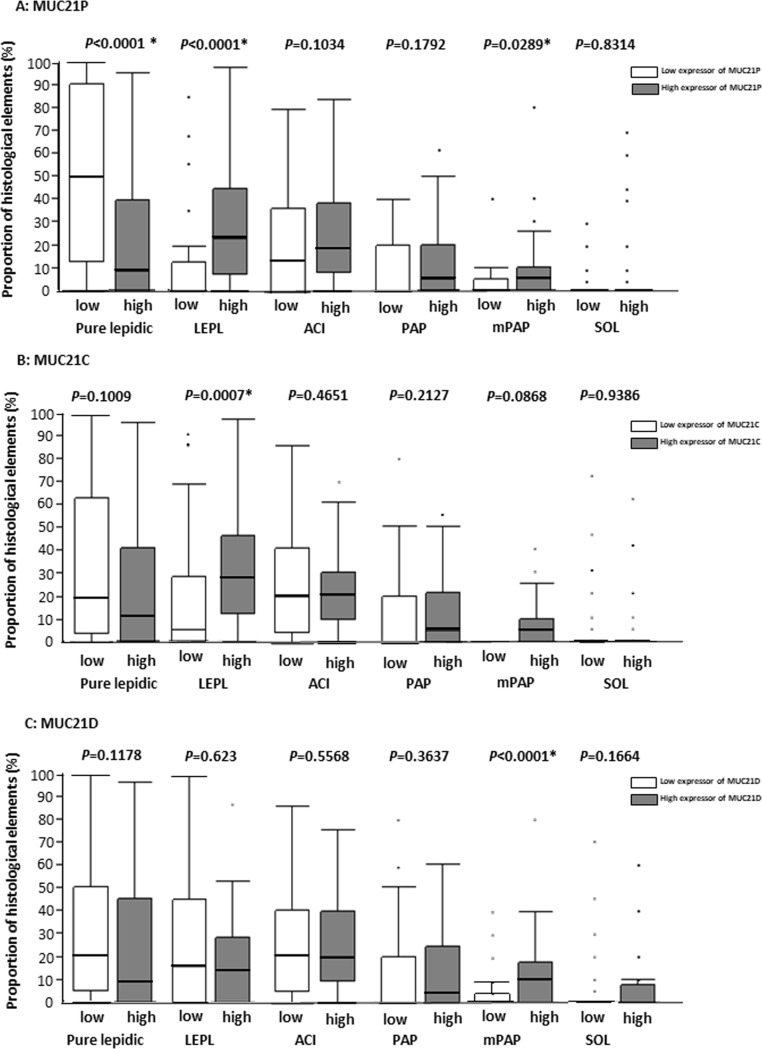
The correlations between the proportions of histological elements and the levels of MUC21 immunohistochemical expressions.Proportions of histological elements are displayed as a box-and-whiskers plot (median, thick line; 25th to 75th percentile, box; 10th to 90th percentile, whiskers; outliers, dots). A total of 116 EGFR-mutated lung adenocarcinomas were examined. P-values were calculated using the Mann-Whitney test. High expressors of MUC21P had a significantly higher proportion of lepidic elements with low papillary structure (LEPL) and micropapillary (mPAP) elements (A). High expressors of MUC21C had a significantly greater proportion of LEPL (B). High expressors of MUC21D had a significantly greater proportion of mPAP elements (C). Abbreviations, LEPL; lepidic element with low papillary structure, ACI, acinar; PAP, papillary; mPAP, micropapillary; SOL, solid; Asterisk (*), statistically significant.